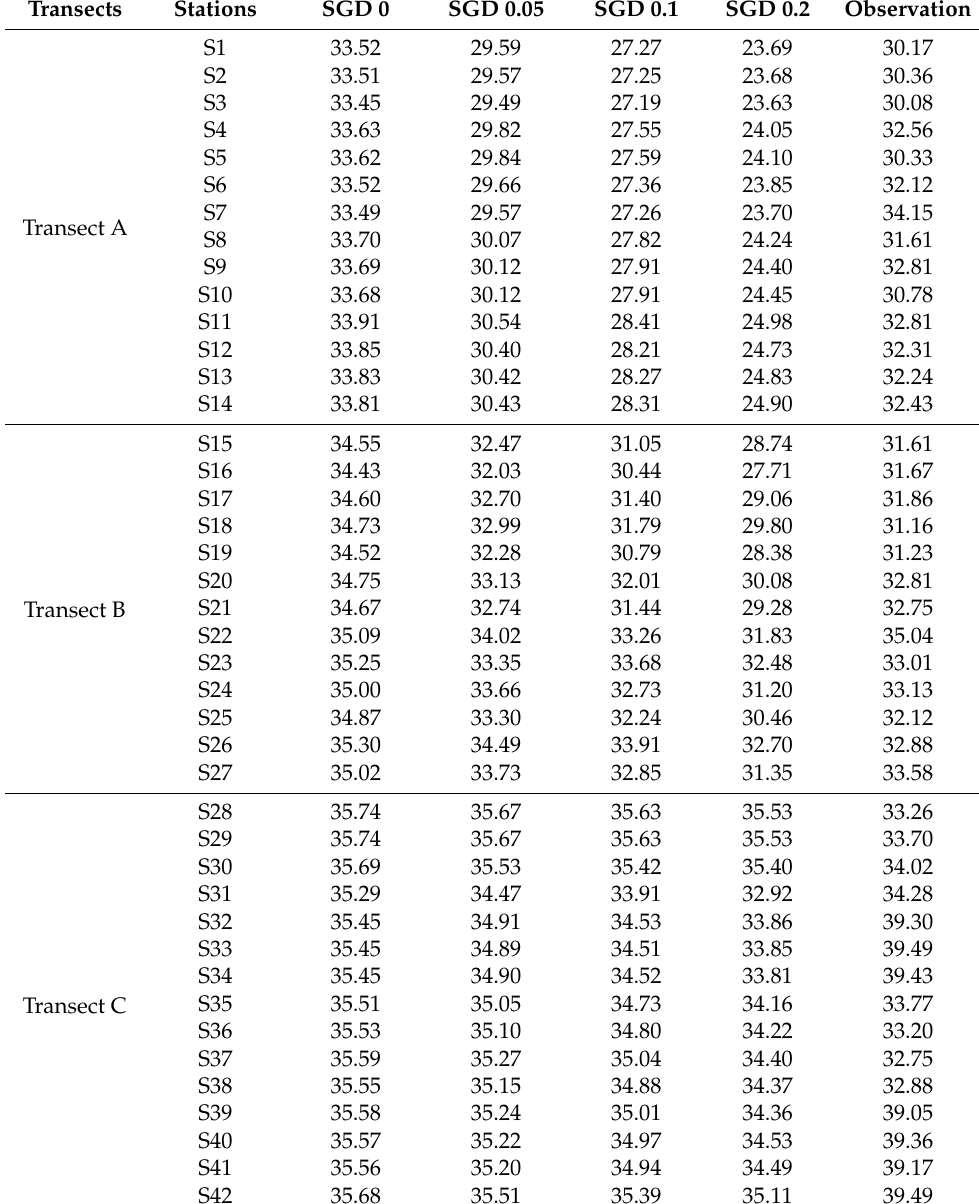
Table A2. Modeled salinity (PSU) in 42 stations for each estimated SGD input